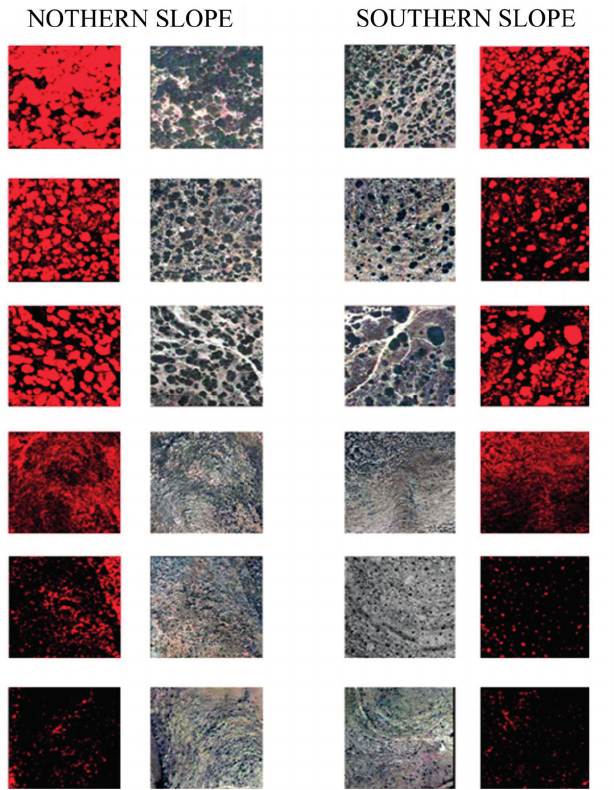
Figure 8. Plot areas extracted from air photographs of six field sites and their segmentation into shrubs versus soil/rock fractions (in red). At each field site there was a plot area in both south and north facing slopes.